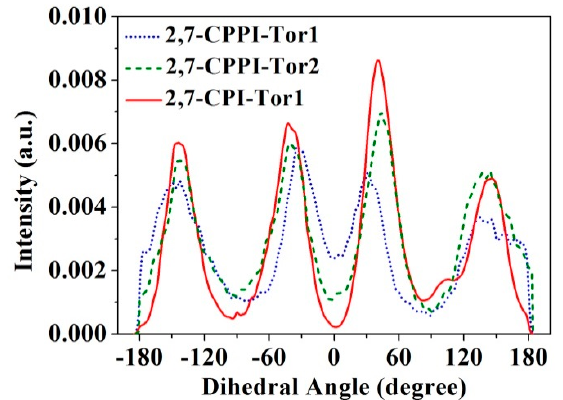
Figure 11. Dihedral angle profiles of the 2,7-CPPI and 2,7-CPI. (Schematic diagrams of the analyzed atomic segments are shown in Figure S3).